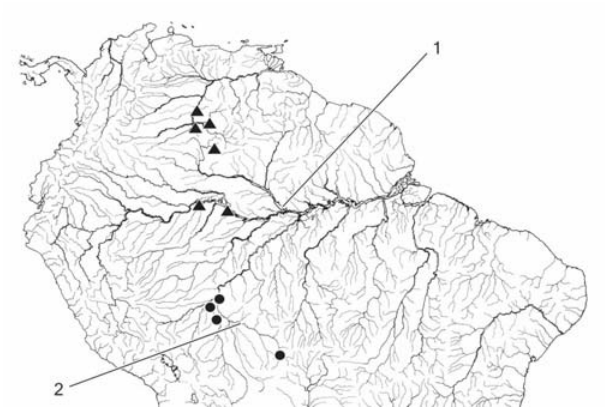
Fig. 10. Map of central and northern South America showing distribution of Auchenipterichthys punctatus (triangles; ho- lotype locality inexact = “probably Brazil”, 1 = holotype local- ity of Auchenipterichthys dantei ), and A. thoracatus (dots; 2 = Guaporé, presumably = rio Guaporé, the type locality of species) (some symbols represent more than one locality or lot